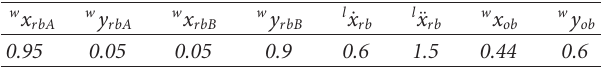
Figure 15: Experimentally-sensed obstacle velocity. Table 1: Static obstacle-avoidance simulation